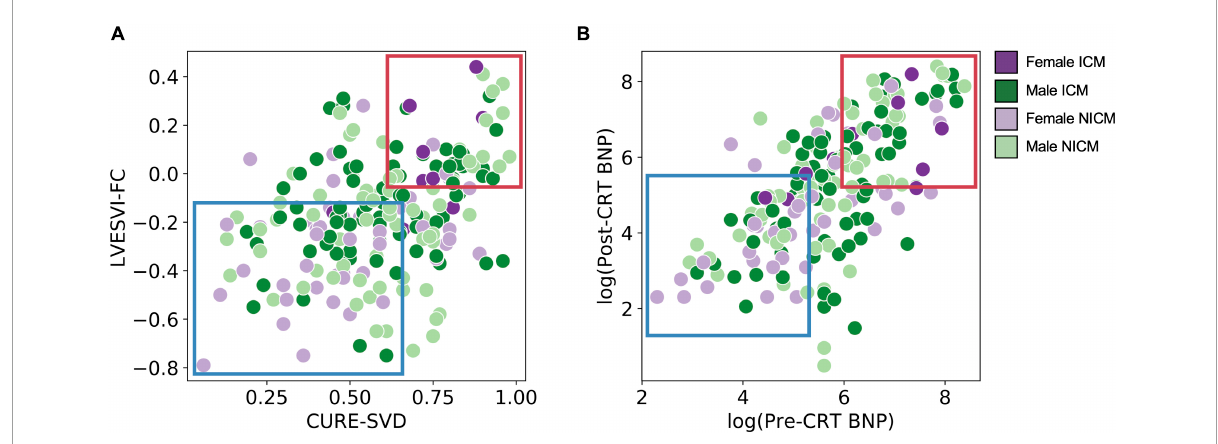
FIGURE5 Scatter plots of pre-CRT parameters versus post-CRT response measures for stratified cohort. (A) CURE-SVD versus LVESVI-FC for all patients is shown with color and shade based on grouping. Many of the darker points (ICM) appear in the highlighted upper right-hand corner (larger CURE-SVD and positive, unfavorable LVESVI-FC) while many of the lighter points (NICM) appear in the highlighted lower left-hand corner (lower CURE-SVD and negative, favorable LVESVI-FC). Many of the green points (male) appear in the highlighted upper right-hand corner while many of the purple points (female) appear in the highlighted lower left-hand corner. (B) log(pre-CRT BNP) versus log(post-CRT BNP) is shown and exhibits similar trends. The plot in panel (A) demonstrates clustering of LVESVI-FC and CURE-SVD by sex/cardiomyopathy group, while the plot in panel (B) demonstrates differences in BNP by sex/cardiomyopathy